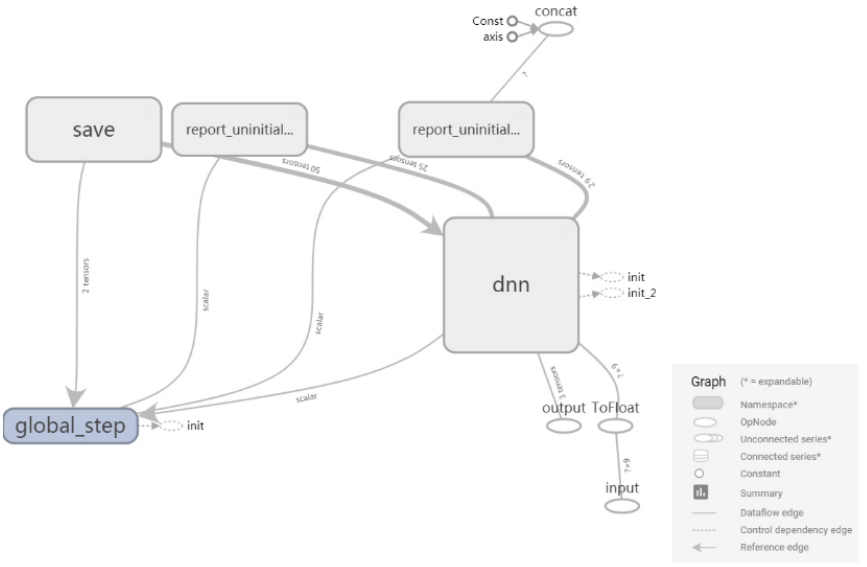
Figure 4. The complete Main Graph of the model.